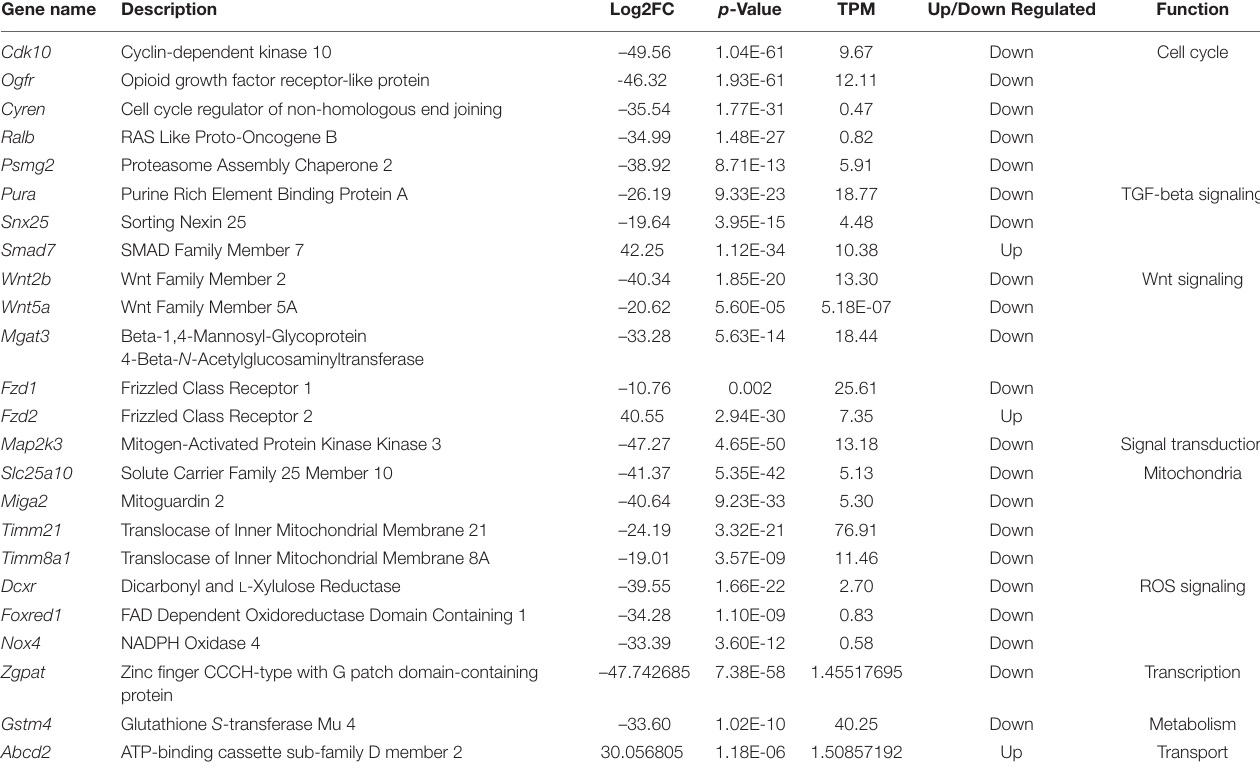
TABLE 2 | Top most significant DEGs in oocytes from primordial follicles between in vivo and in vitro